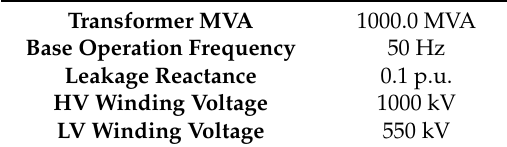
Table 2. Parameters of the transformer at bus N.